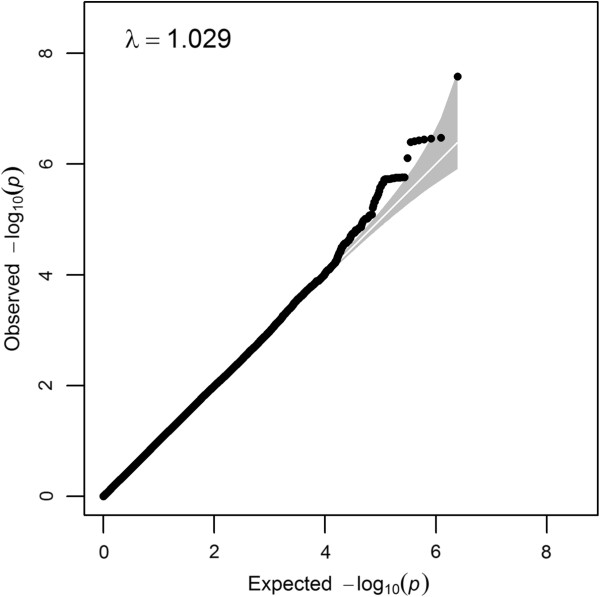
Quantile-quantile plot for the genome-wide analysis of social communication difficulties in ALSPAC. The plot is based on genomic-control corrected P-values. Black circles depict the observed association signals, the white diagonal line represents the distribution of signals under the null hypothesis and the shaded area corresponds to the 95% confidence interval. A deviation of the observed from the expected distribution of signals is visible. λ, Genomic-control factor.